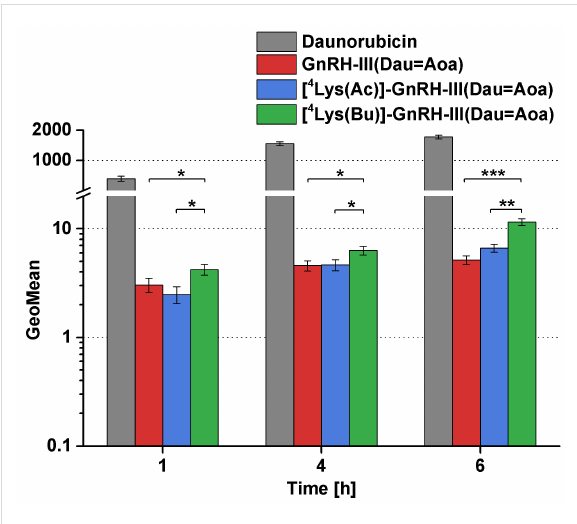
Figure 2: Cellular uptake of Dau–GnRH-III conjugates and free daunorubicin (Dau) by A2058 cells. Cellular uptake of the compounds was studied in 10 − 5 M concentration. GeoMean (geometric mean channel) value is a dimensionless value and refers to the relative fluo- rescence intensity. Data shown are mean of 2 parallels ± SD. The levels of significance are shown as follows: *: p < 0.05; **: p < 0.01, ***: p <